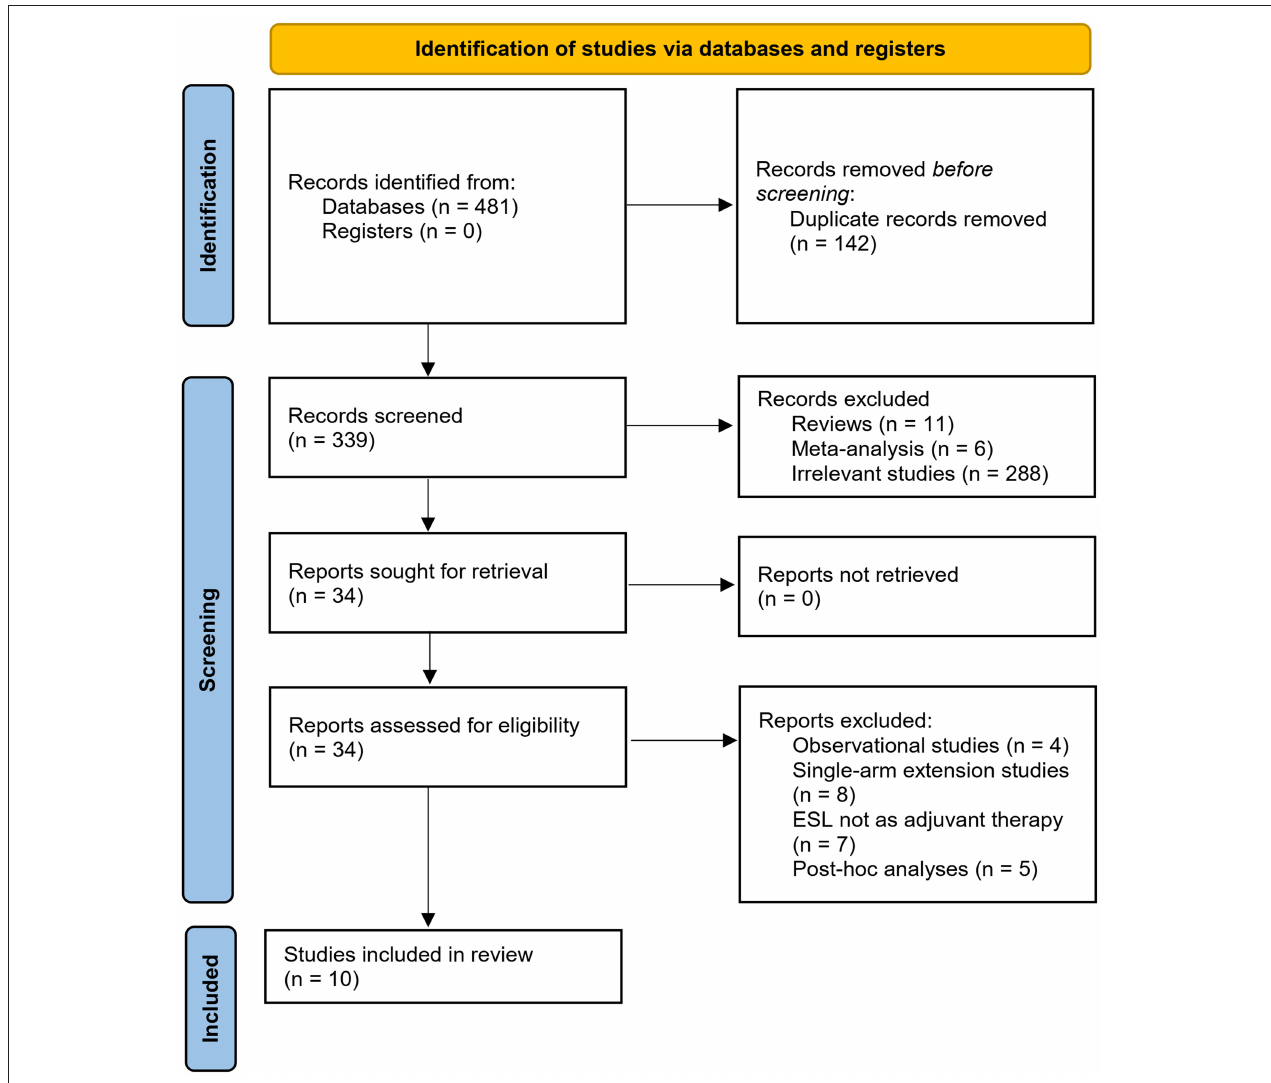
FIGURE 1 | Flowchart of literature